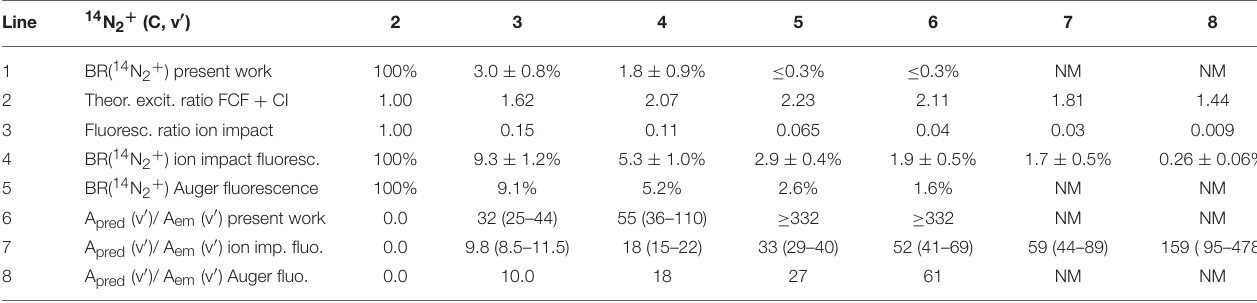
2–8 of the C 2 6 + u , state of 14 N 2 + . =